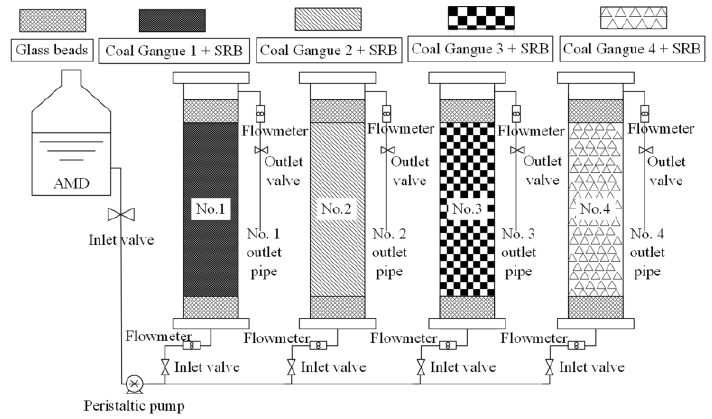
Figure 1. System diagram of testing device.